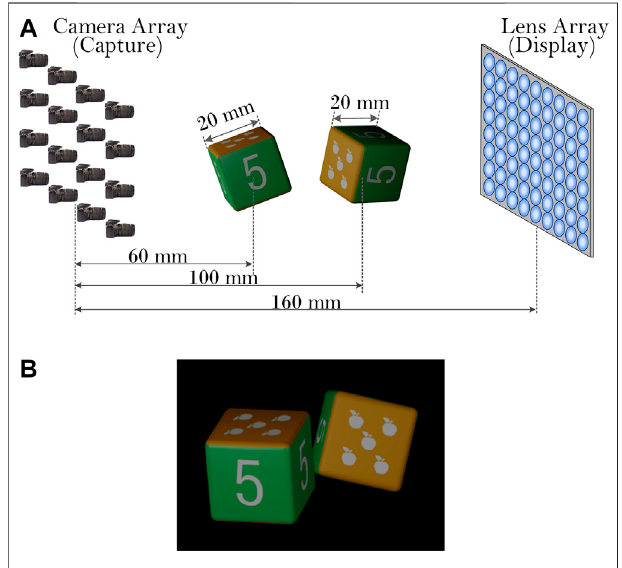
FIGURE 8 | (A) Scene settings for the virtual acquisition experiment. (B) The frontal scene